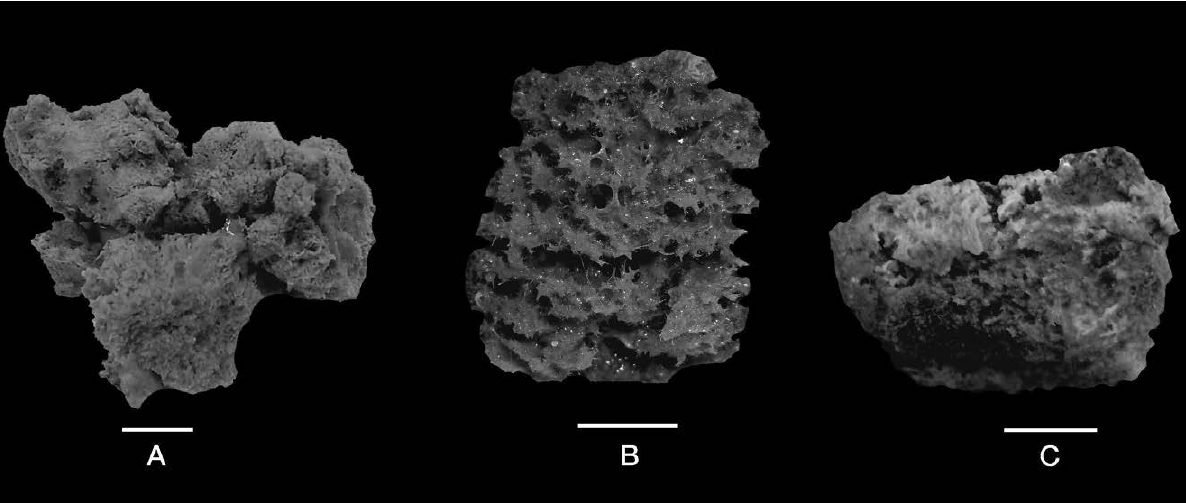
Fig . 1. – A, Acarnus erithacus de Laubenfels, 1927 Fragment of the Allan Hancock Pacific Expedition (AHF 1085-40). B, Vase-shaped sponge from deeper waters. C, Acarnus peruanus van Soest et al., 1991 Preserved specimen from the Mexican Pacific. Scale: A, B, 1.5 cm: C, 1